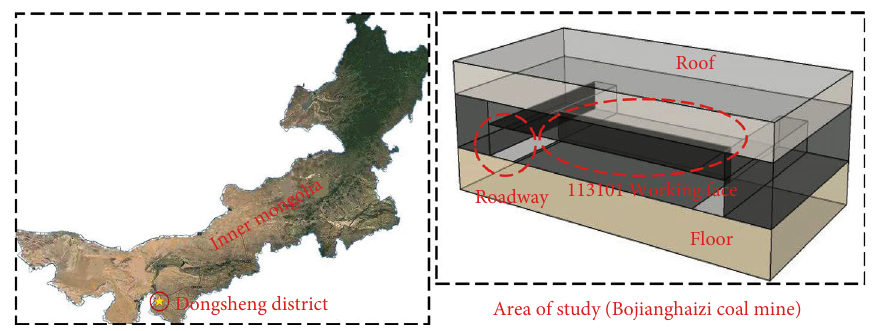
Figure 1: Roadway research geographical